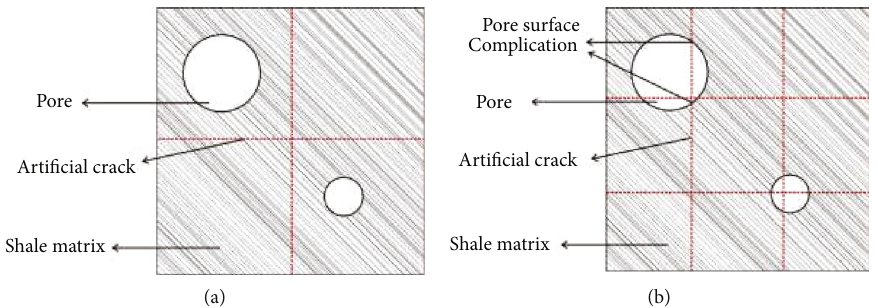
Figure 10: E ff ect of particle size on shale pore structure: (a) larger shale particle size; (b) smaller shale particle